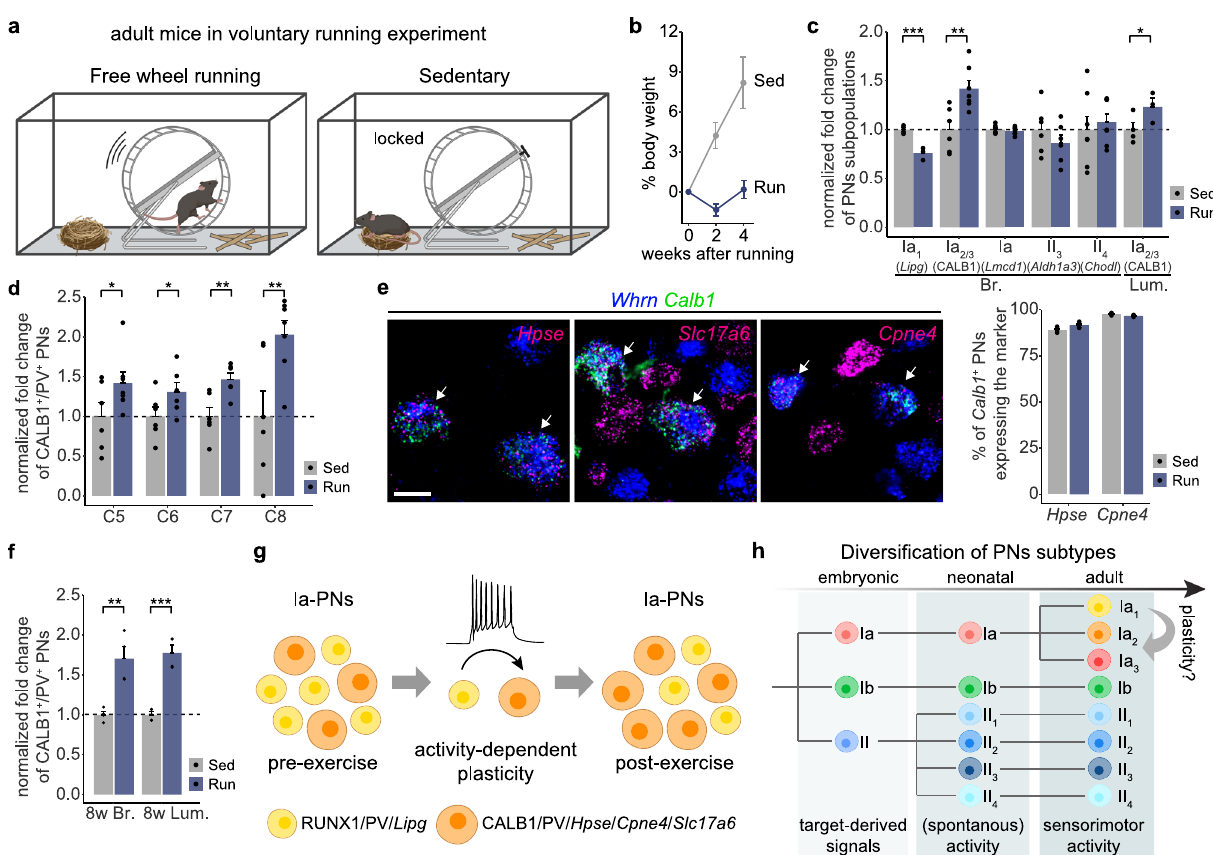
Fig. 6 Activity-driven plasticity of adult Ia-PN subtypes. a Schematic depiction of the housing environment during the voluntary running experiment. b Percentage of weight change in sedentary (Sed) and free wheel running (Run) groups. Data are presented as mean ± SEM ( n = 7 animals for both groups). c Fold change of proportion of PN subtypes in 4-week running group compared with sedentary group: Lipg + / Whrn + cells (Ia 1 ) among Whrn + cells, CALB1 + /PV + cells (Ia 2/3 ) among PV + cells, and Lmcd1 + / Whrn + (Ia), Aldh1a3 + / Whrn + (II 3 ), and Chodl + / Whrn + (II 4 ) cells among Whrn + cells. Ia 1 : n = 4 animals for sedentary group and n = 3 animals for running group; Ia 2/3 (Br.): n = 6 animals for sedentary group, n = 7 animals for running group; Ia: n = 7 animals for both groups; II 3 : n = 6 animals for both groups; II 4 : n = 7 animals for both groups; Ia 2/3 (Lum.): n = 4 animals for sedentary group, n = 3 animals for running group. Data are presented as mean ± SEM; dots represent values from individual animals. One-tailed t -test, * p < 0.05, ** p < 0.01, *** p < 0.001. d Fold change of proportion of CALB1 + /PV + PNs in individual brachial segments in 4-week running group compared with sedentary group ( n = 7 animals). Data are presented as mean ± SEM; dots represent values from individual animals. One-tailed t -test, * p < 0.05, ** p < 0.01. e RNAscope images showing the expression of other Ia 2/3 -PN markers (magenta) in Calb1 + PNs ( Whrn + ) on the brachial DRG sections of the running mice. Scale bar: 20 µ m. Right: percentage of Calb1 + PNs expressing other Ia 2/3 markers in sedentary and running groups, respectively ( n = 4 animals). Data are presented as mean ± SEM; dots represent values from individual animals. f Fold change of proportion of CALB1 + /PV + PNs in 8-week running group compared with sedentary group ( n = 4 animals). Data are presented as mean ± SEM; dots represent values from individual animals. One-tailed t -test, ** p < 0.01, *** p < 0.001. g Schematic summarizing the results from the voluntary running experiment. h Model of the diversi fi cation of PN subtypes. Br: brachial DRG (C5-8); Lum: lumbar DRG (L2-5). Source data are provided as a Source Data fi